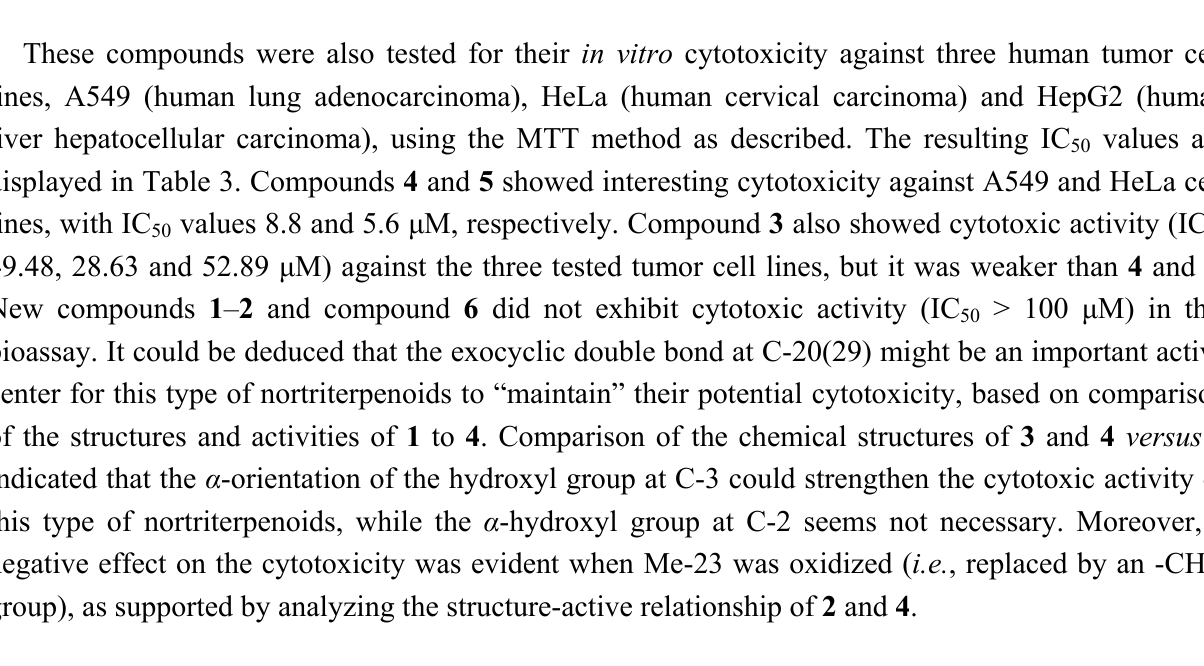
Table 3. Cytotoxicity of compounds 1 – 6 (IC